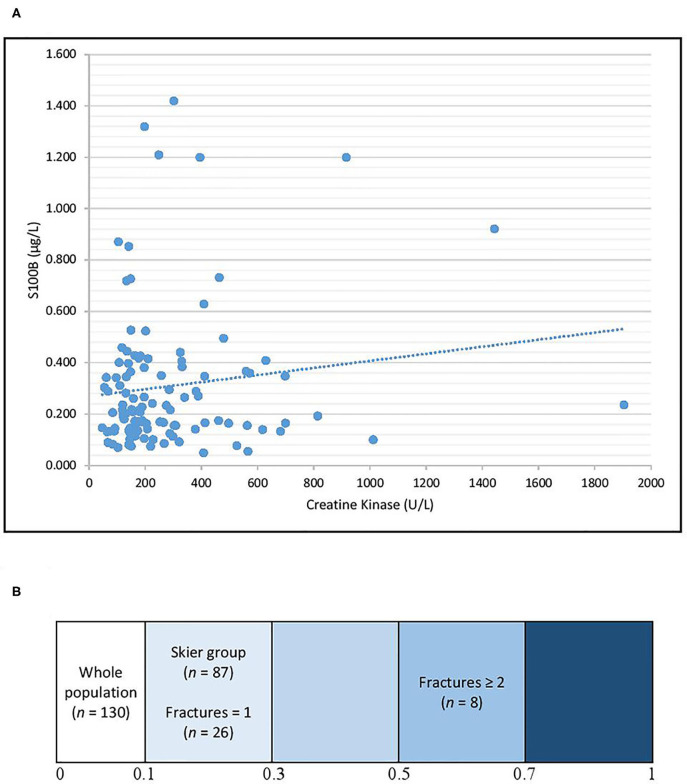
Correlation between S100B and CK for the whole study population (A) and heatmap representing the Spearman's correlation coefficients for different subgroups (B). The Spearman's correlations coefficients were 0.07 for the whole population, 0.19 for the skier group, 0.13 for patients that suffered only one fracture, and 0.57 for patients that suffered at least two fractures.